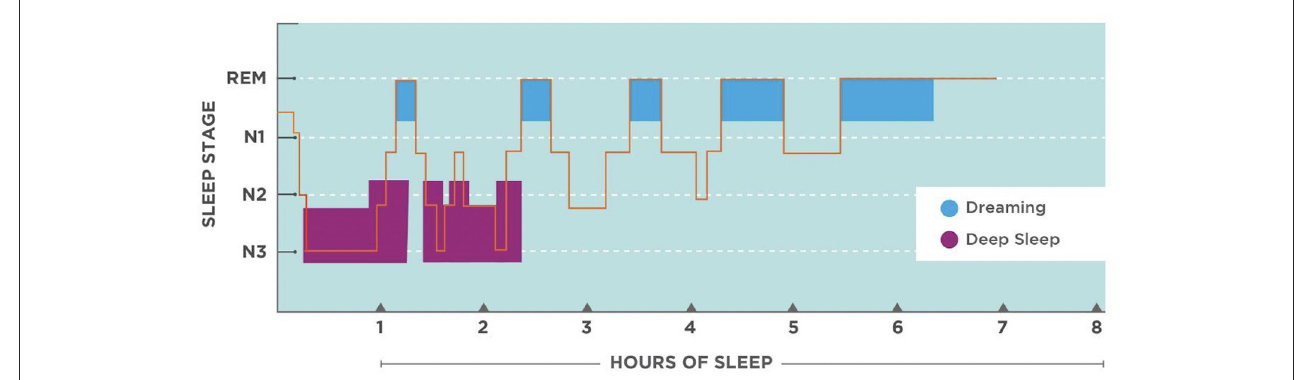
FIGURE2 Hypnogram of a normal healthy adult. Image courtesy of Patrick Alban, DC and Deane Alban. https://bebrainfit.com/binaural-beats-meditation.